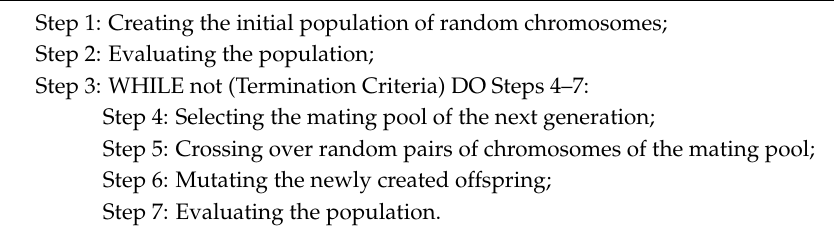
Algorithm 1. Main steps of genetic algorithms